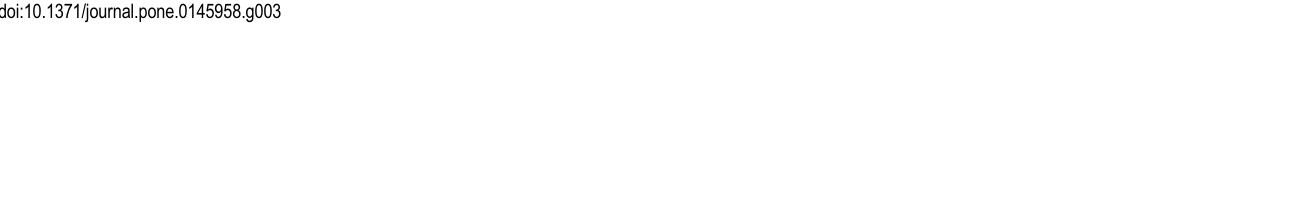
PLOS ONE | DOI:10.1371/journal.pone.0145958 February 18,